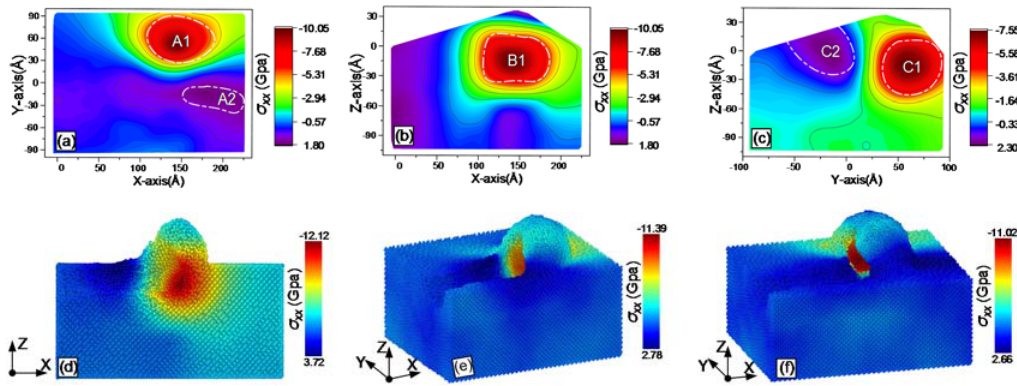
Figure 9. Snapshots of the normal stress σ xx after the atomic-scale curve grinding: ( a ) on X–Y plane; ( b ) on X–Z plane; ( c ) on Y–Z planes; ( d ) at the front point of the arc, ( e ) at the rear of the arc; and ( f ) at the end of the tool.